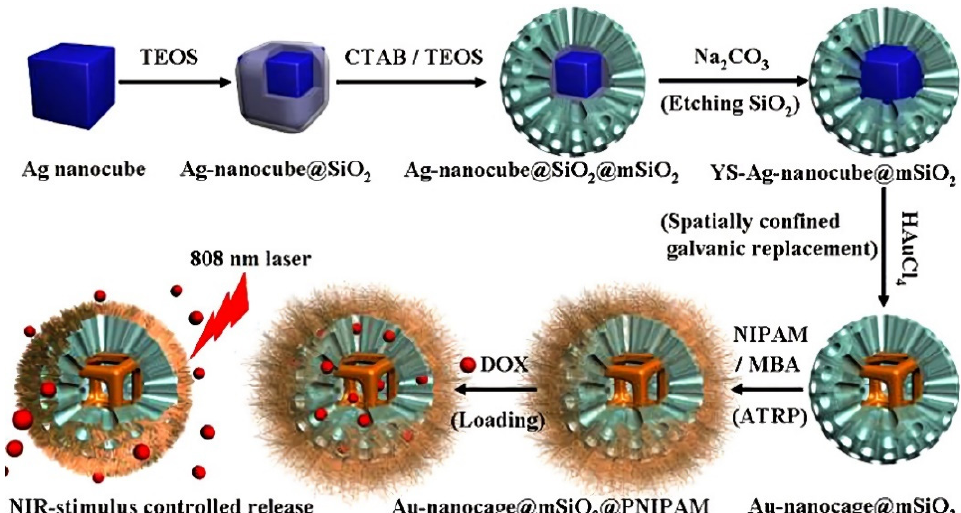
Figure 8. Schematic illustration of the NIR light-responsive Au-nanocage@mSiO 2 @PNIPAM for controlled drug release. Reprinted/adapted with permission from Ref. [81]. Copyright 2013, American Chemical Society.